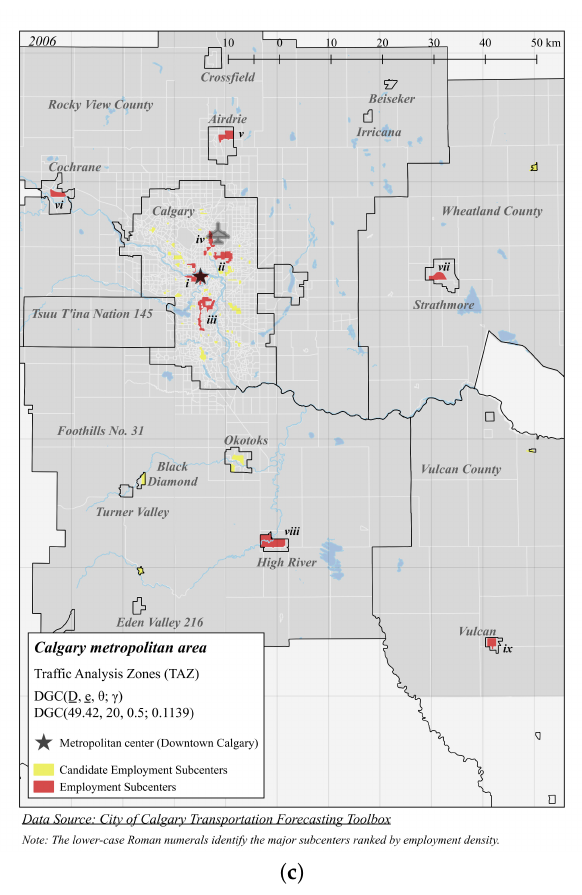
Figure 5. Calgary metropolitan area subcenters identified by: ( a ) DGC(49.42, 20, 0; 0.1139); ( b ) DGC(49.42, 20, 1; 0.1139); ( c ) DGC(49.42, 20, 0.5;